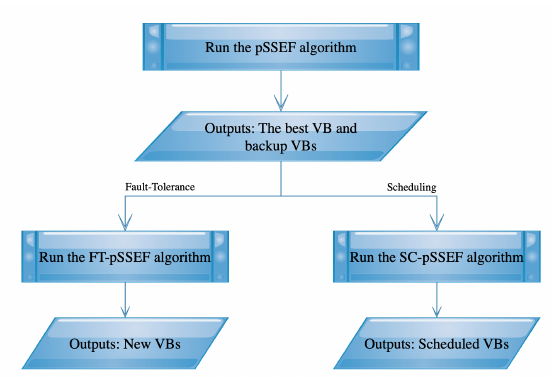
Figure 4. Implementations of the pSSEF algorithm to the VB fault-tolerance and